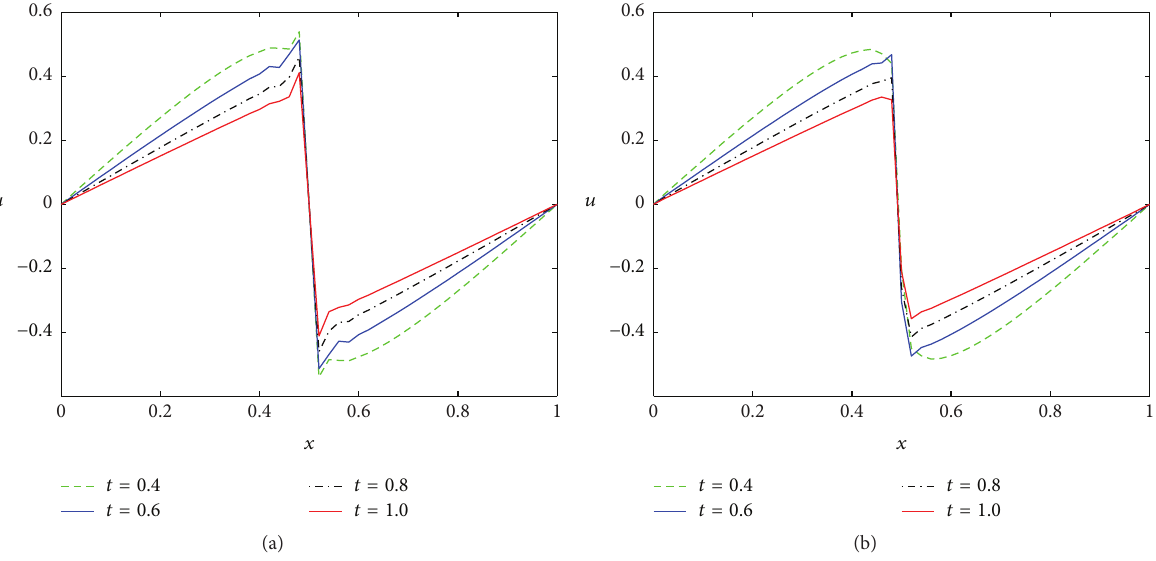
Figure 10: Solutions 𝑢(𝑥,𝑥, 𝑡) of the VMEFG wihout filter (a) and with low-pass filter (b) at different times for Re = 10 3 .